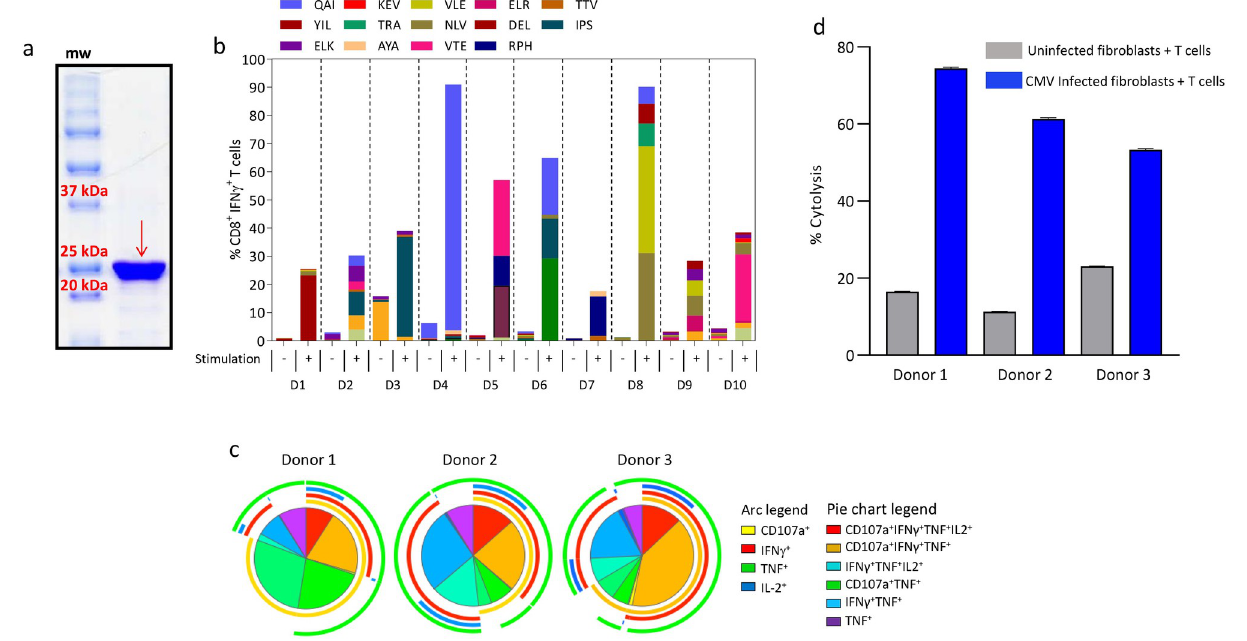
Fig 1. CMVpoly protein purification, characterisation and in vitro immunogenicity analysis. (a) SDS-PAGE showing purified CMVpoly protein with a molecular weight of 25.1 kDa. (b) In vitro expansion of CMV-specific CD8 + T cells from healthy CMV seropositive donor PBMCs following stimulation with CMVpoly protein. Briefly, PBMCs from healthy donors were stimulated with CMVpoly protein (20mg) and cultured for 14 days in the presence of IL-2. These in vitro expanded T cells were assessed for CMV epitope-specific reactivity in an intracellular cytokine assay. Bar graph represent the comparative frequencies of IFN- γ expressing CMV-specific CD8 + T cells in unstimulated PBMCs and in vitro expanded T cells. (c) Pie chart shows polyfunctional profile of CMVpoly stimulated CD8 + T cells comprised of various combinations of CD107a + , IFN γ + , TNF + and/or IL-2 + . Arc indicates the proportion of CMV-specific CD8 + T cells producing individual function: CD107a (yellow) IFN γ (red), TNF (green) and IL-2 (blue). (d) Antigen- specific CD8 + T cells expanded with CMVpoly protein kill CMV-infected fibroblasts. Human fibroblasts expressing HLA A � 01:01, A � 02:01 and B � 08:02 were infected with CMV TB40/E strain and then exposed to CMVpoly stimulated CD8 + T cells from three different donors at an effector to target ratio of 1:1 and for 48 hours and the cytotoxicity response was monitored in real time using xCELLigence and percent lysis was determined. Uninfected fibroblasts were used as control in this assay. Bar graph represents the average of percent cytolysis from 4 replicates at 48 h time-point and error bars represent the standard error of mean.